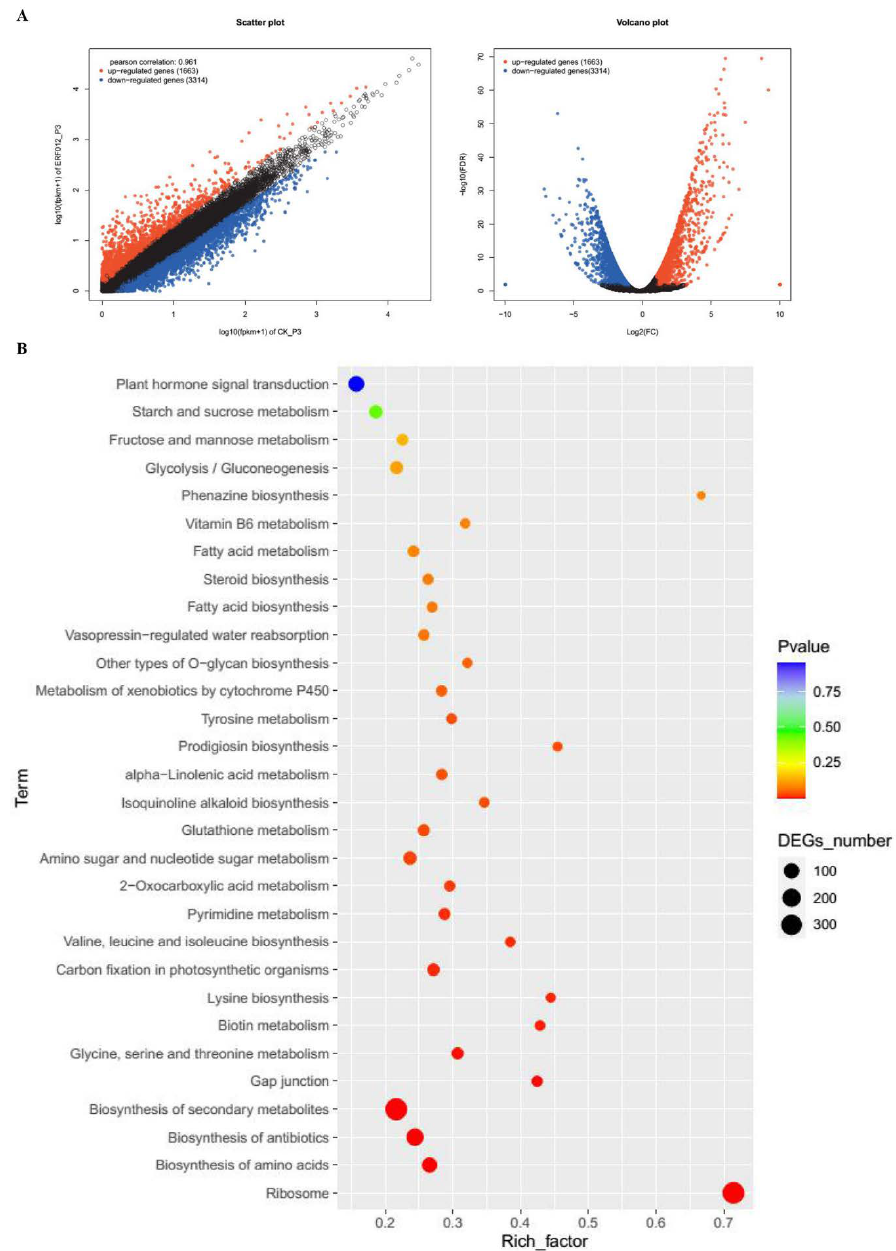
Figure 8. Comparison of the DEGs identified in MaERF012 -overexpression and WT lines in fruit pulp. ( A , B ) volcano plot ( A ) and KEGG enrichment ( B ) of the DEGs identified across WT and MaERF012 -overexpression lines.